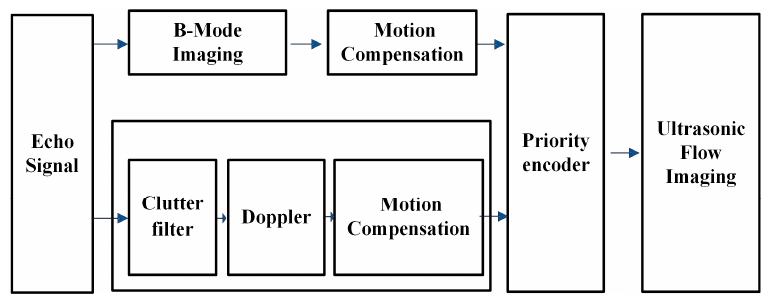
Figure 6. The processing fl owchart of ultrasonic fl ow imaging.